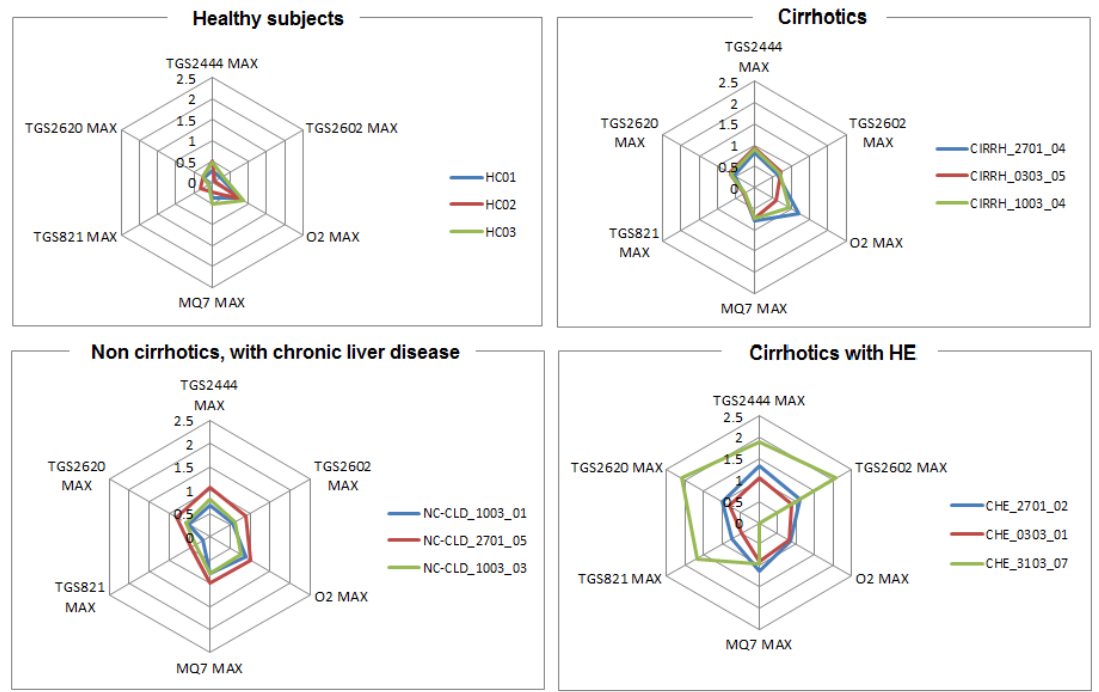
Figure 4. Comparison of radar plot profiles relative to HC, NC-CLD, CIRRH and CHE. Radar plots showed a concordant rise in value for TGS2444 and TGS2602 (sensitive to ammonia) maximum output, from HC to CHE subjects. However, a change in the whole sensors’ outputs pattern can be